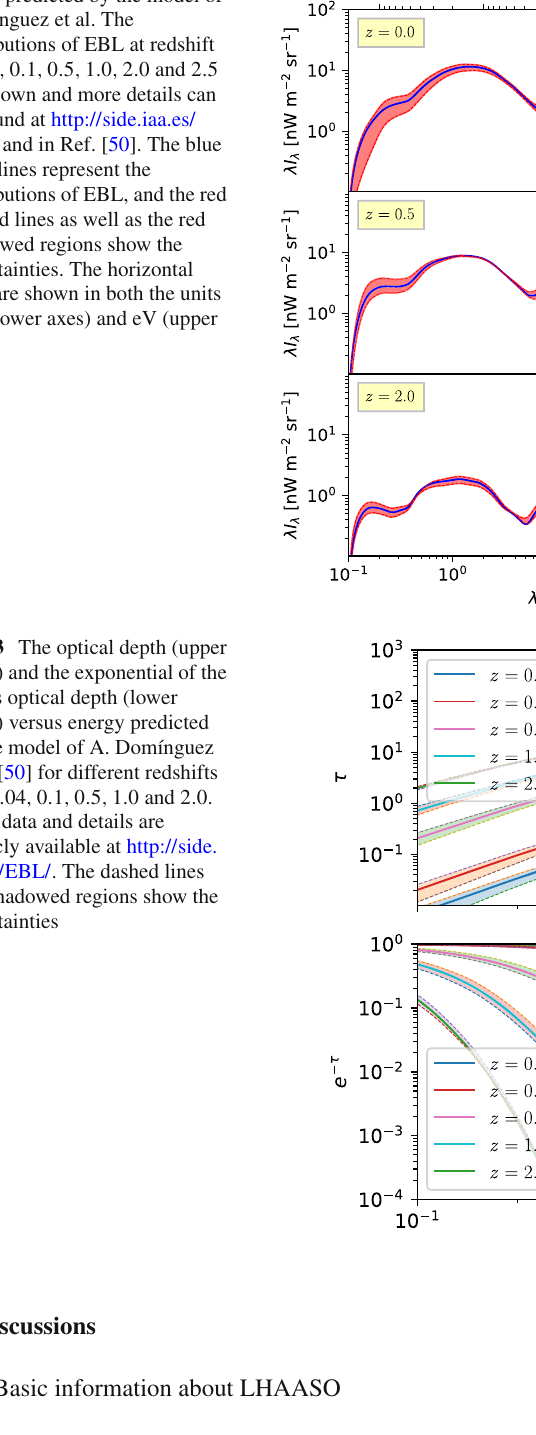
Fig. 2 EBL in a comoving frame predicted by the model of Domínguez et al. The distributions of EBL at redshift z = 0 , 0 . 1 , 0 . 5 , 1 . 0 , 2 . 0 and 2 . 5 are shown and more details can be found at http://side.iaa.es/ EBL/ and in Ref. [50]. The blue solid lines represent the distributions of EBL, and the red dashed lines as well as the red shadowed regions show the uncertainties. The horizontal axes are shown in both the units μ m (lower axes) and eV (upper axes)